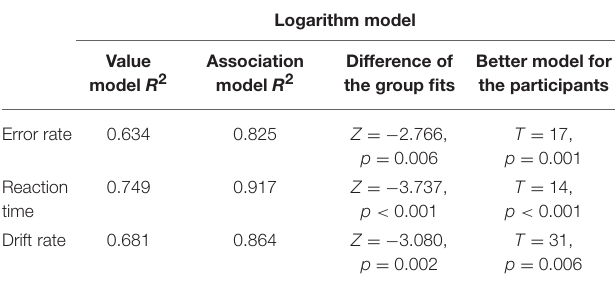
TABLE 4 | Goodness of fit of the models (measured as R 2 ) and comparison of the correlations (Difference column) for the error rates, reaction times, and drift rates based on the group average data, and hypothesis tests for choosing the better model based on the participants’ data in the Indo-Arabic study (Kojouharova and Krajcsi,